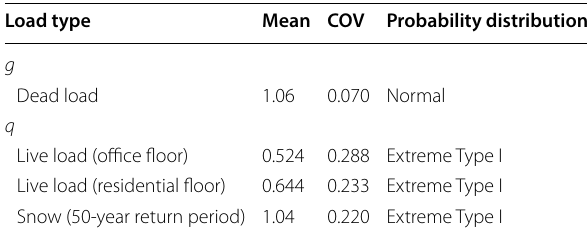
Table 4 Statistical parameters of loads for the China analysis method